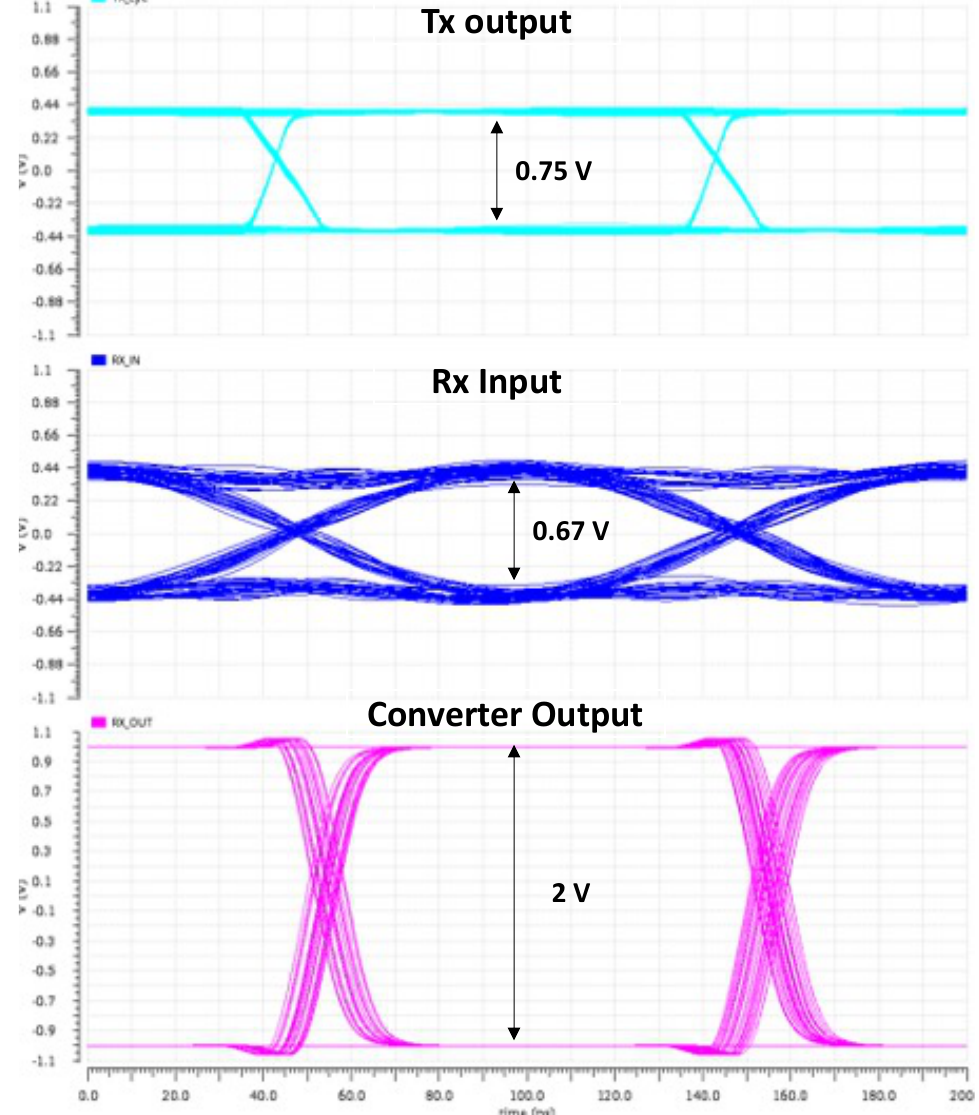
Figure 14. The simulation results of CML-to-CMOS converter: ( top ) before channel; ( middle ) after channel; and ( bottom ) after